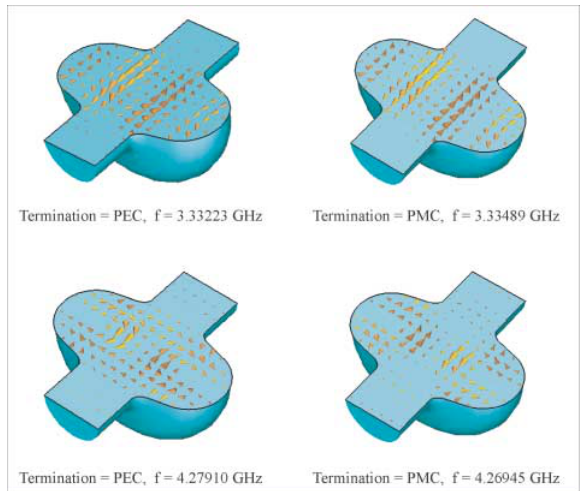
FIG. 2. (Color) Electric fields of two modes near f (cid:1) 3.33 GHz and f (cid:1) 4.28 GHz, for which the influence of the beam pipe boundary condition (electric or magnetic) is